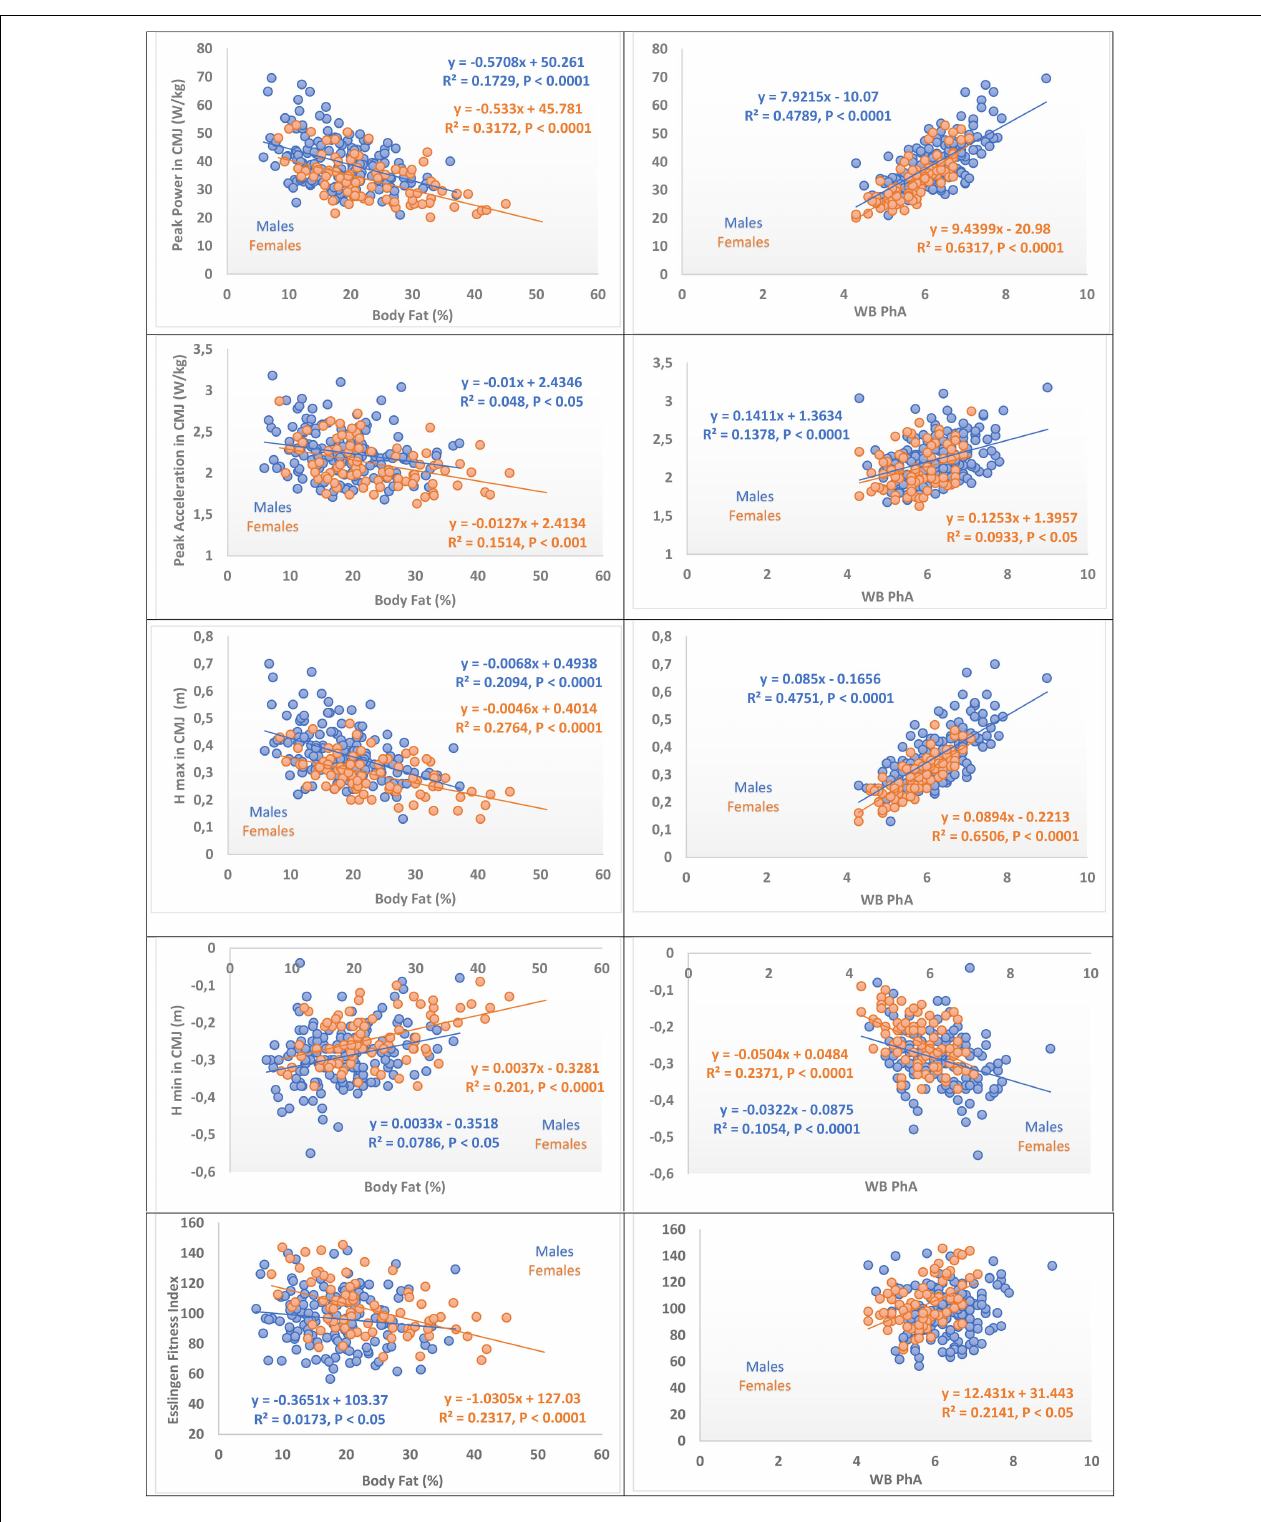
FIGURE 3 | Body composition dependency of vertical jump test variables of master athletes. At left, percent body fat dependency of vertical jump test variables. Comparison of variables by gender. At right, Phase angle dependency of vertical jump test variables. Comparisons of variables by gender, WB PhA, whole body phase angle, regression lines, and equations are represented and consigned when they are significant (see correlation coefficients in Table 5 ).